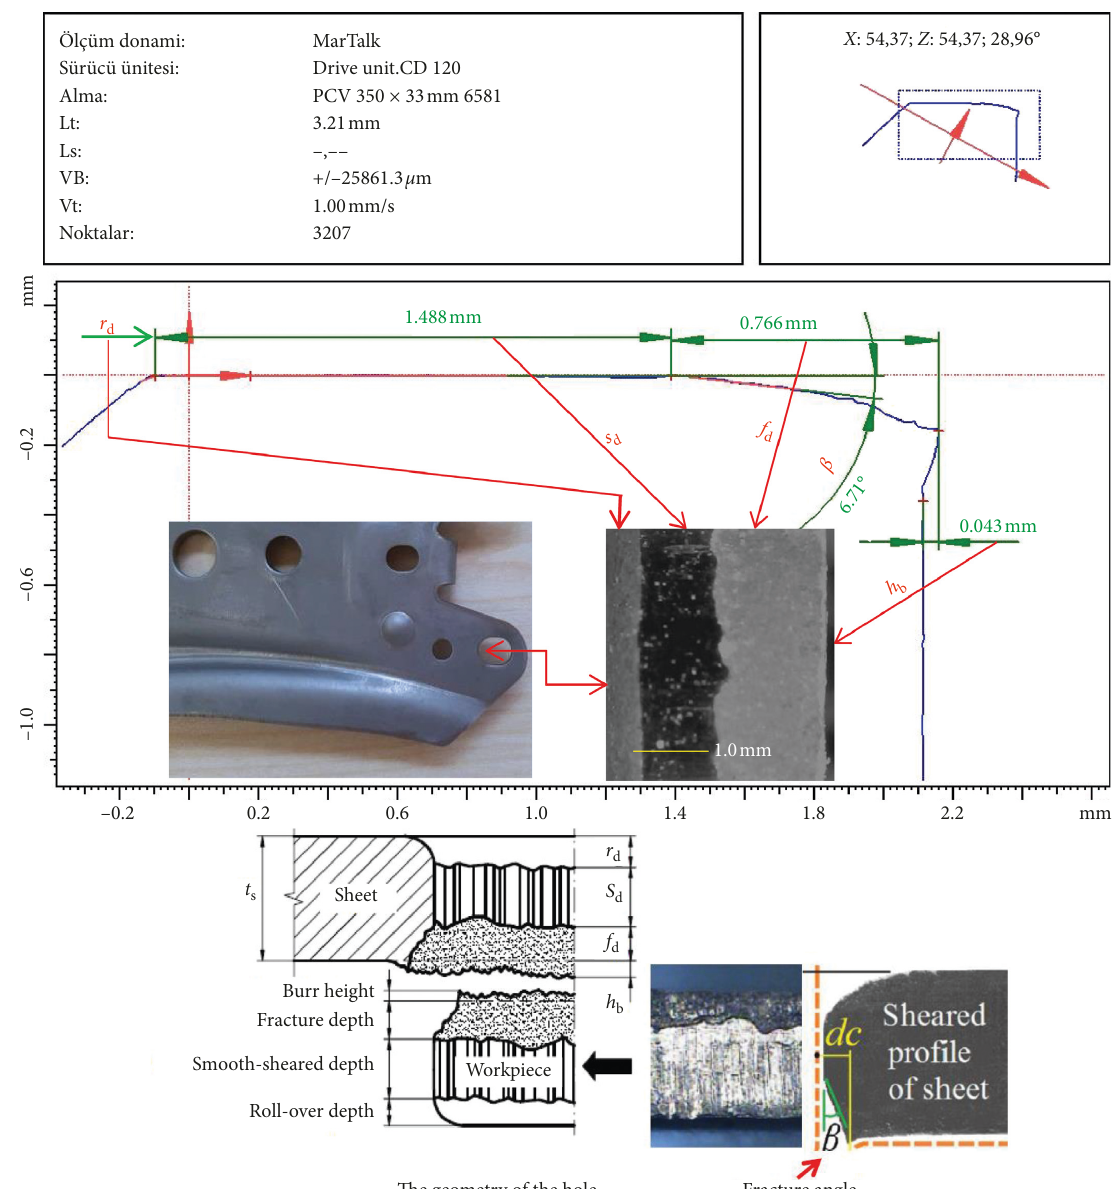
Figure 4: Outputs of contour measuring machine and the geometry of the hole [5].